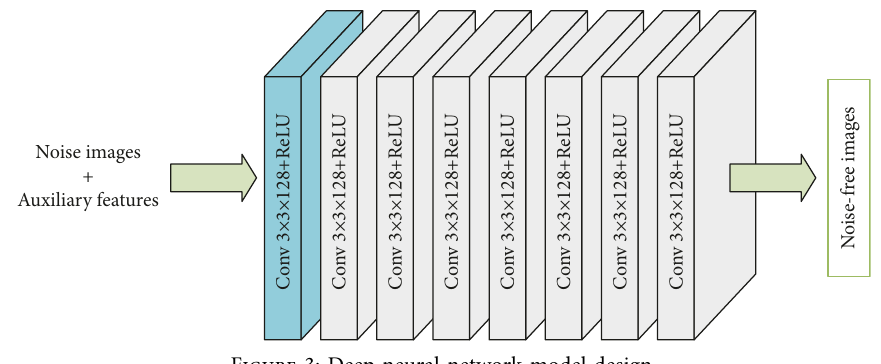
Figure 3: Deep neural network model